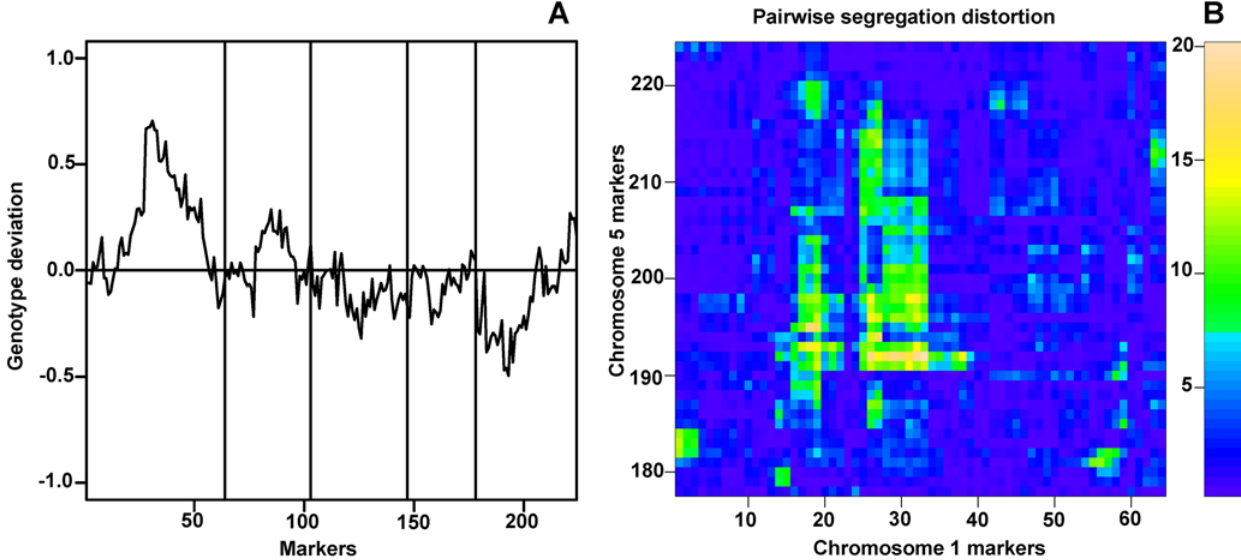
Figure 3. Segregation distortion in EstC AI-RILs. (A) Genotype of 224 markers over all five chromosomes. A value of 1.0 for a given marker represents all Est-1 alleles, while 2 1.0 corresponds to all Col alleles. (B) Chi-squared plot of pairwise segregation distortion for each marker on chromosome 1 and chromosome 5. Only the interaction between chromosome 1 and 5 markers are shown. Markers were consecutively numbered starting from the Northern most marker on chromosome 1. doi:10.1371/journal.pone.0004318.g003 PLoS ONE |